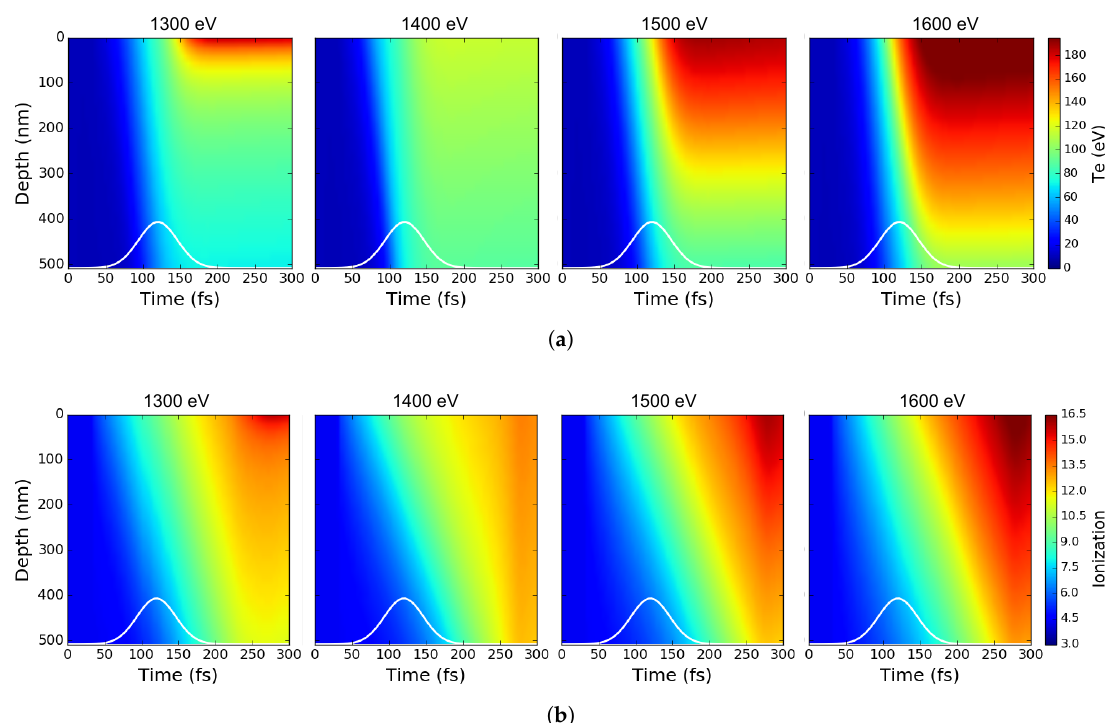
Figure 3. Cretin simulations of the temperature ( a ) and ionisation ( b ) distribution along the target as a function of time for the four photon energies of study. The laser pulse is shown in white. Note how, for the cases in which the photon energy of the laser is such that there is strong absorption (1300, 1500 and 1600eV), the front surface of the target (top region of the images) is much hotter and ionized than the back owing to the rapid absorption of the XFEL radiation before it propagates to the back of the target. However, in the 1400eV case, as the photon energy lies between the bound-bound (L-M) transitions and below most of the L-edges of the ions, the laser is uniformly deposited along the thickness of the target and gradients are